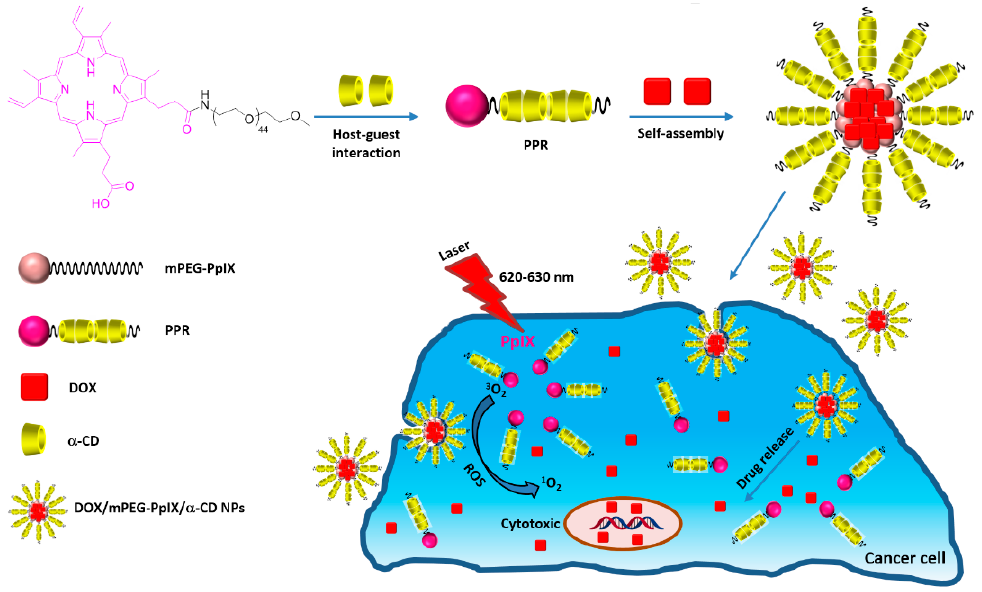
Figure 51. Illustration of polypseudorotaxane doxorubicin (DOX)/mPEG-PpIX/ α -CD NPs with dual